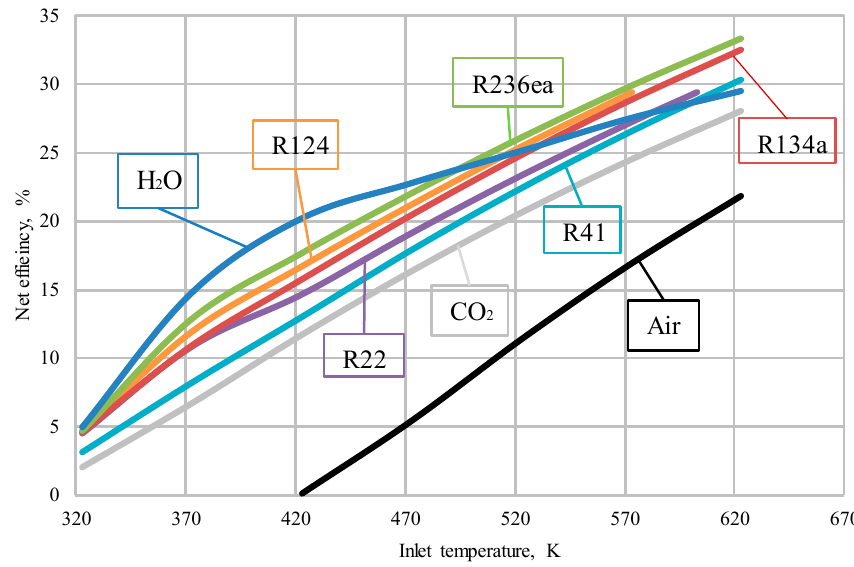
Figure 16. Maximum efficiencies for cycles with regenerator at different initial temperatures.